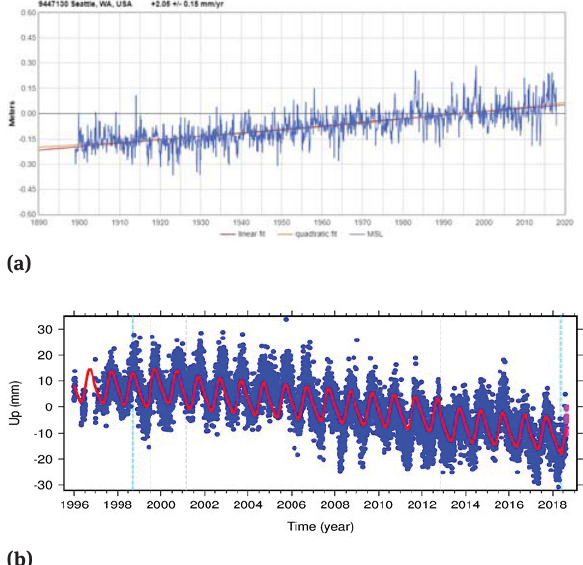
Figure 13: (a) MSL data for Seattle, WA, USA. Image reproduced modified after [4]. (b) GNSS time series for SEAT. Image reproduced modified after NGL.